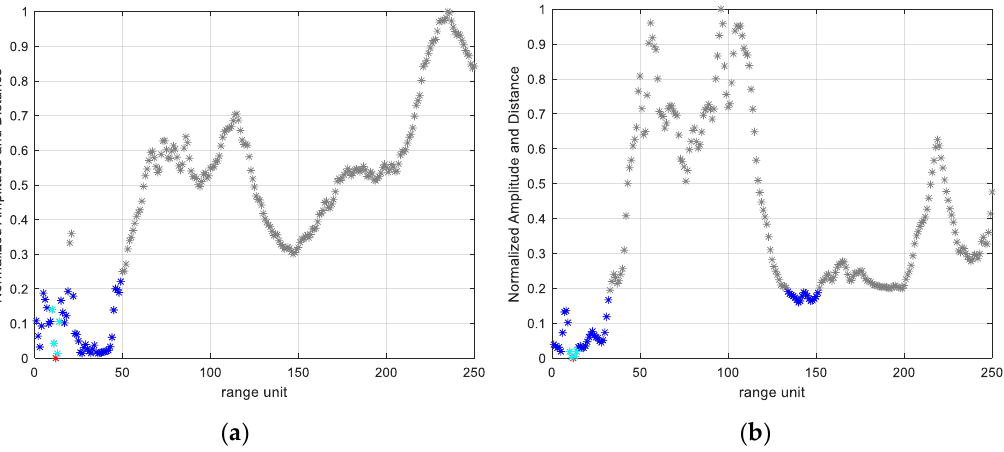
Figure 5. The SLD results of transient interferences in range dimension: ( a ) LCI result; ( b ) STI result.